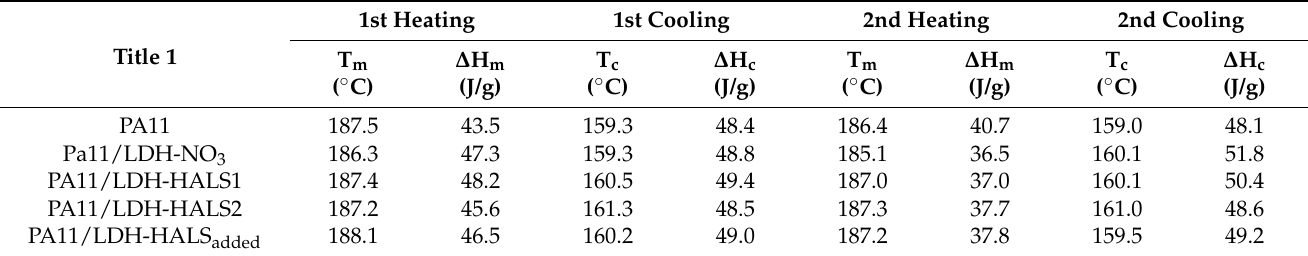
Figure 8. DSC curves (second heating scan) of neat PA11 and all investigated PA11-based nanocomposites. Table 1. DSC data of neat PA11 and PA11-based nanocomposites.